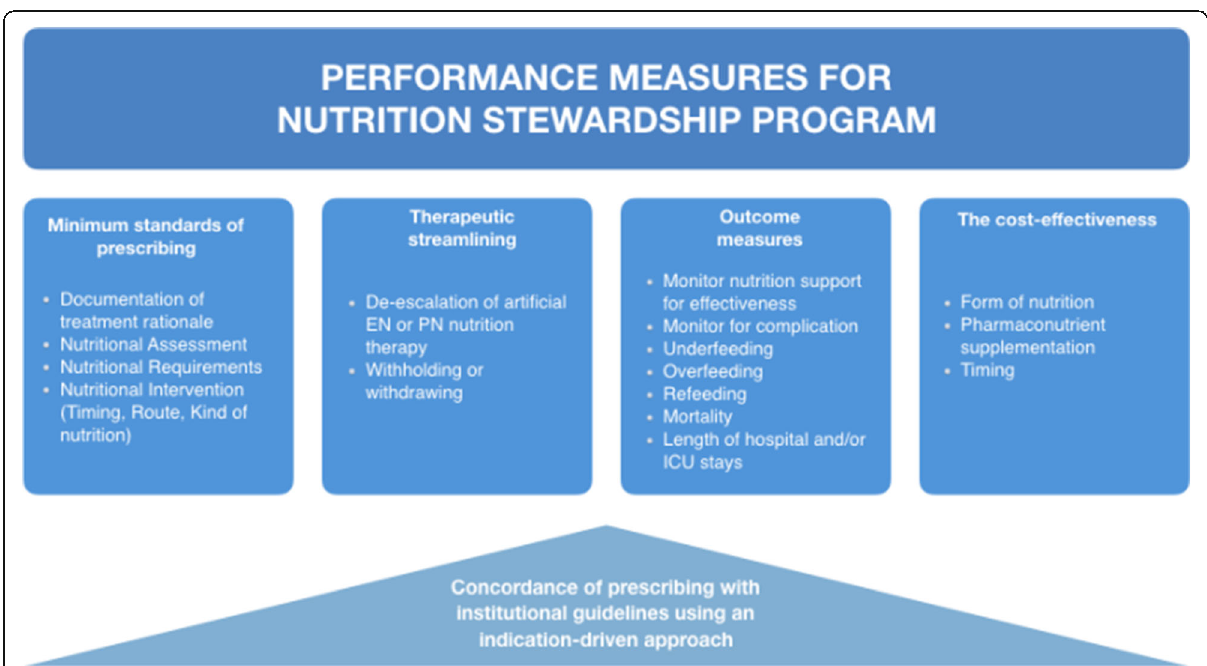
Fig. 2 Performance measures for nutrition stewardship program. EN, enteral nutrition; ICU, intensive care unit; PN, parenteral